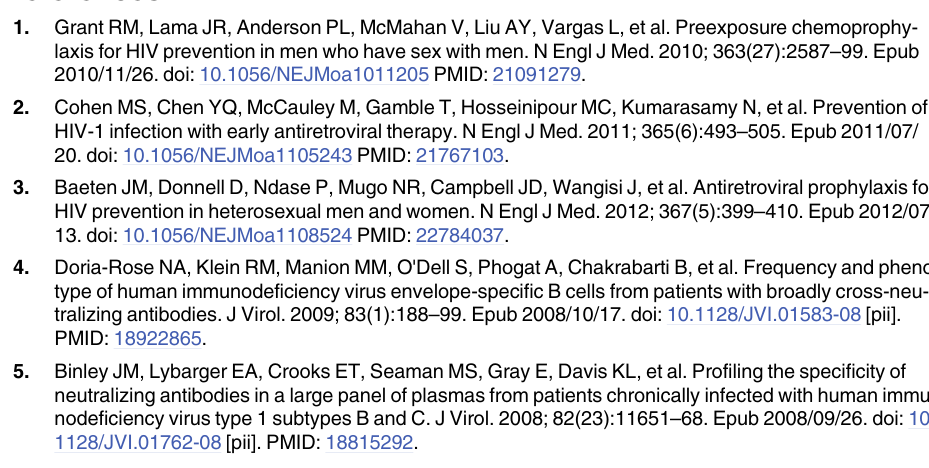
Data represent mean ± SD. S7 Fig. Frequency of Tfh and GC B cells in mice immunized with several adjuvants or gp140 alone. BALB/c mice (n = 5 per group) received 2 doses of the adjuvants CFA/IFA,